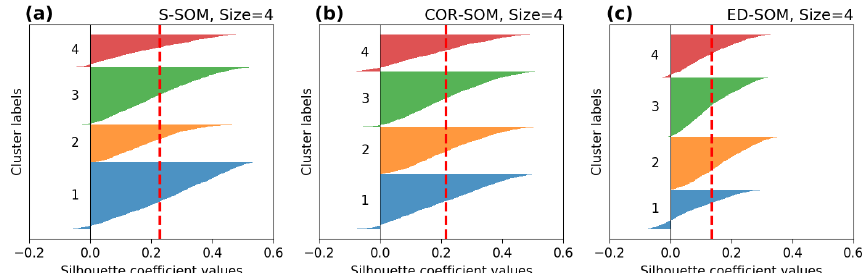
Figure A5. Silhouette plot for S-, COR-, and ED-SOM clustering for spring months (MAM). Note that these are results from simulations with the SOM-node size of 4. The vertical dashed red lines in each plot indicate the silhouette score.